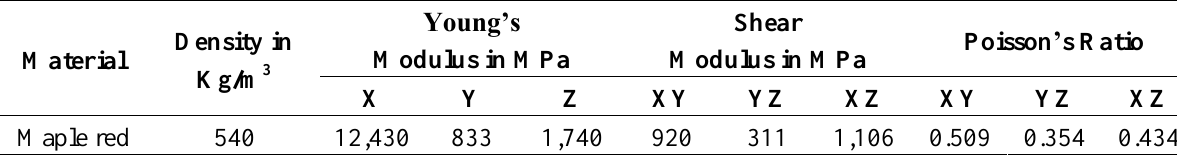
Table 1. Material properties of the violin bridge used in the simulation.